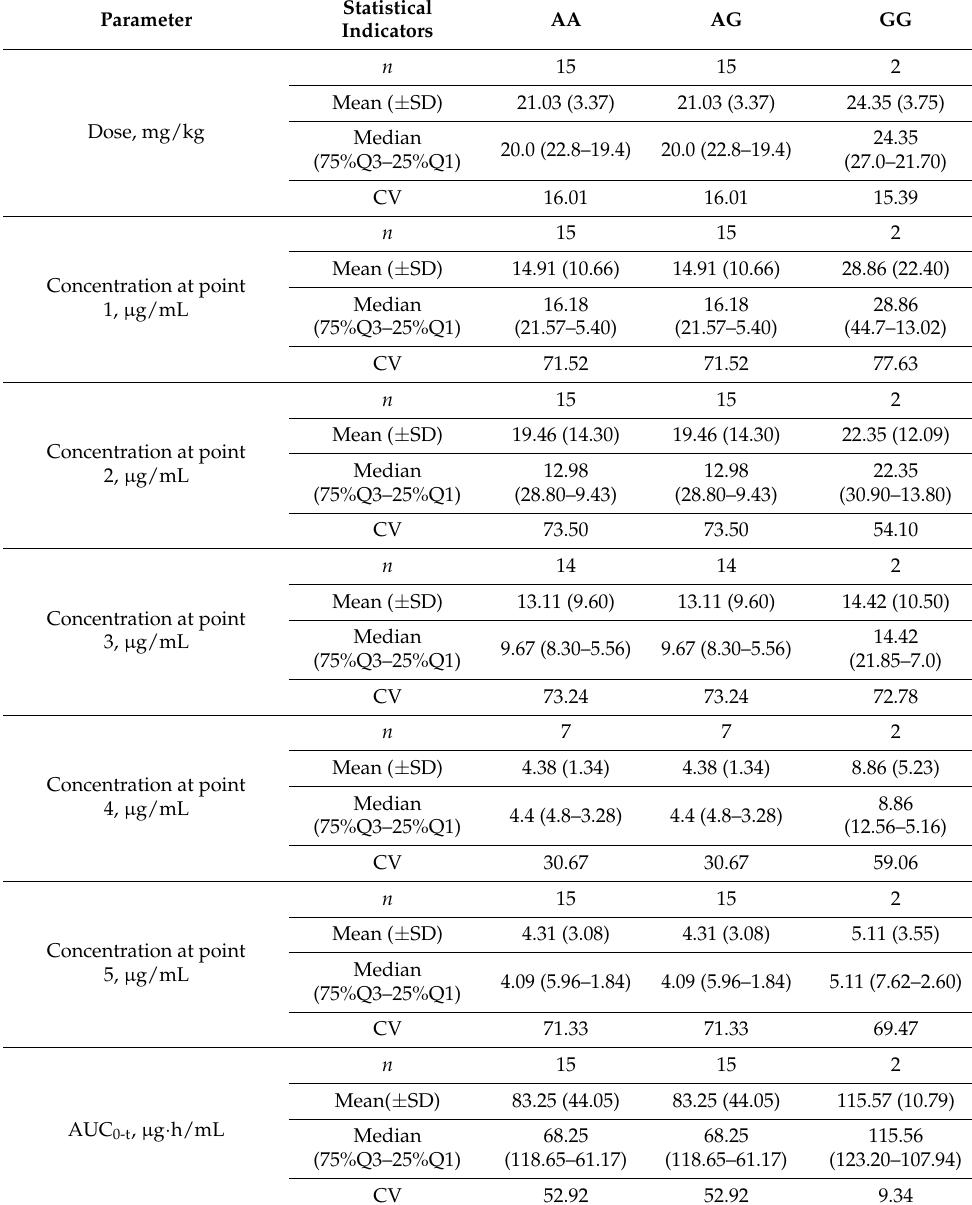
Table 10. Pharmacokinetic parameters of ciprofloxacin in children with CF with different types of the GSTP1 gene